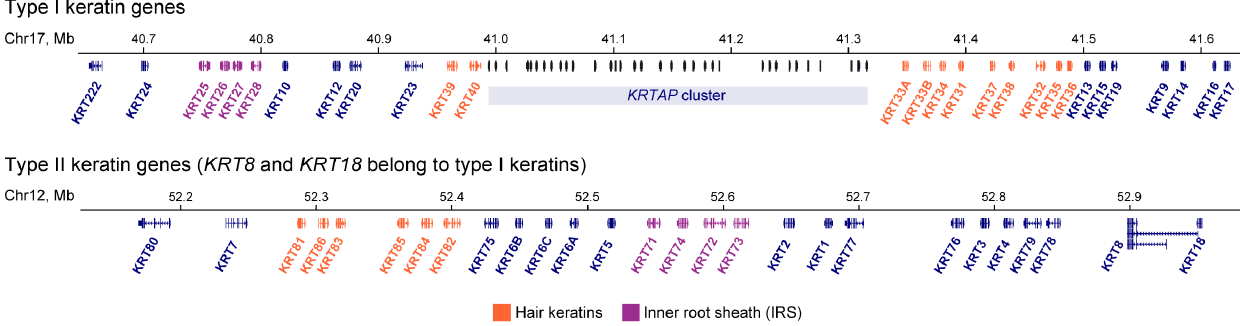
Figure 1. Loci of human keratin genes. Adopted from the UCSC genome browser. KRTAP—an array of genes encoding keratin-associated proteins.